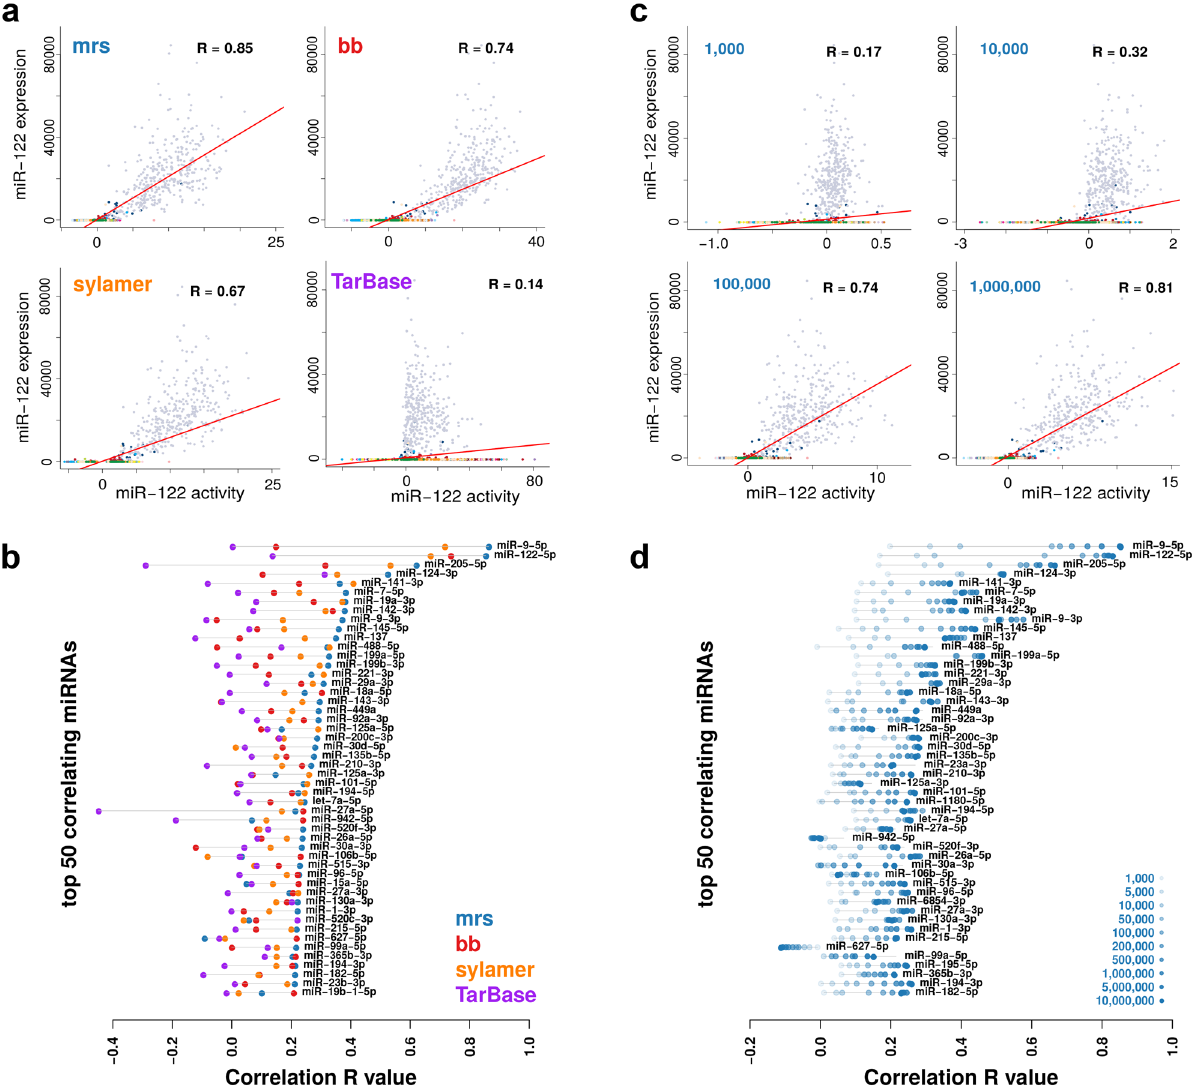
Figure 2. Method evaluation. a Correlation of miR-122 activity with expression for the four different motif enrichment methods across the TCGA data set (n = 9679). b Correlation values for the 50 miRNAs with highest correlation between activity and expression for any of the four activity score evaluation methods. c plots as in ( a ) based on the mrs method for downsampled TCGA data sets. d Correlation values for top 50 miRNAs as in ( b ) based on the mrs method for 10 different downsampled TCGA data sets with indicated number of total read counts per sample (shades of